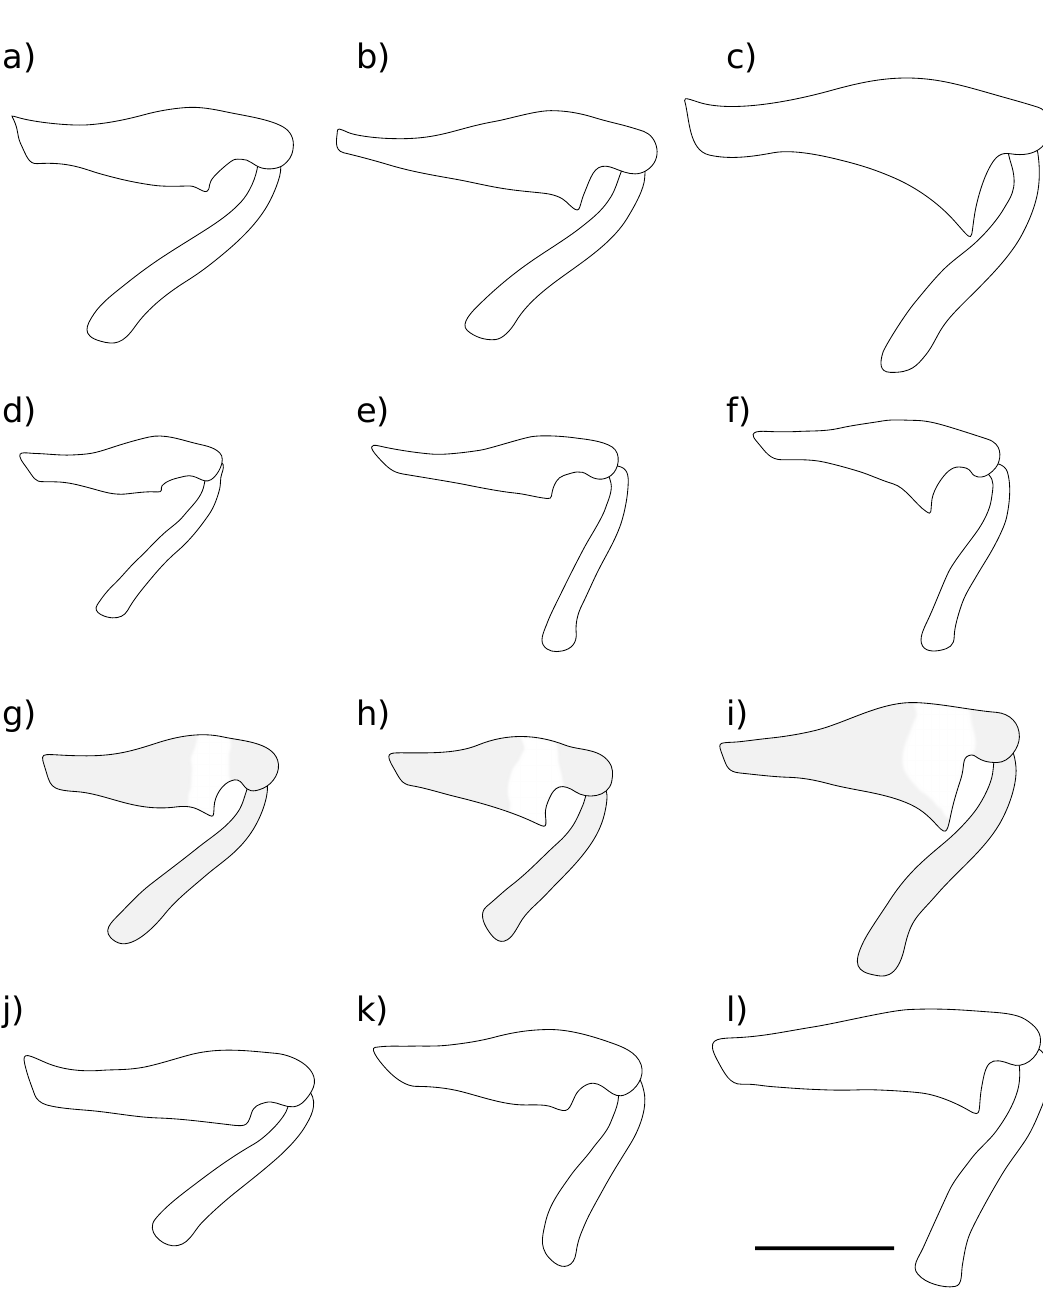
Figure 5. Left femora and tibae, anterior view, of Kuschelysius species. Kuschelysius hollowayae